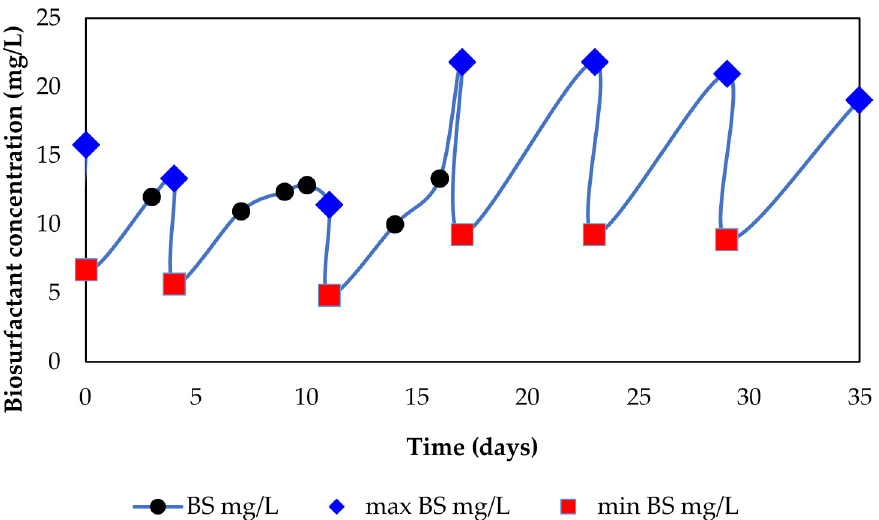
Figure 3. Biosurfactant concentration cycle in sequencing batch reactor. Time zero is after a 10-day batch operation period. Max BS represents the BS concentration just before removing 60% of the cultures volume (rhombus). Min BS represents the BS concentration just after adding new ONR7a and nutrients to fill up the bioreactor (square). Black circles represent sampling points in between the min and max values.